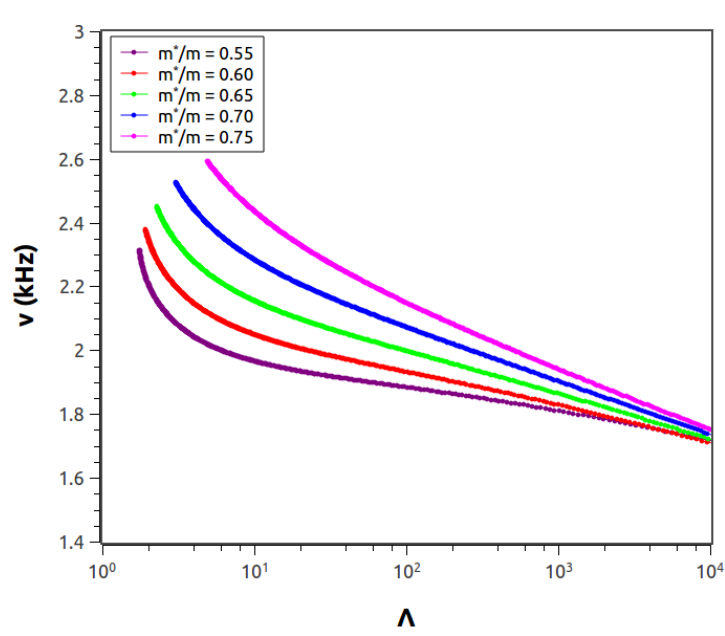
Figure 6. The f -mode frequencies ν as a function of tidal deformability Λ for varying m ∗ / m